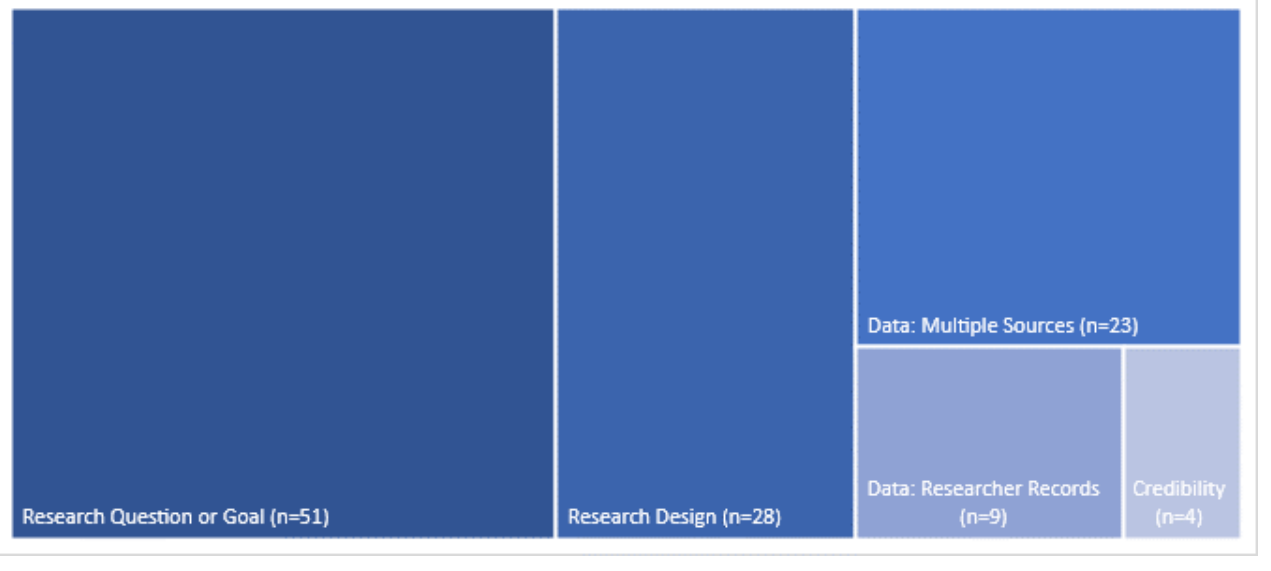
Figure 1. Features of Practitioner Research